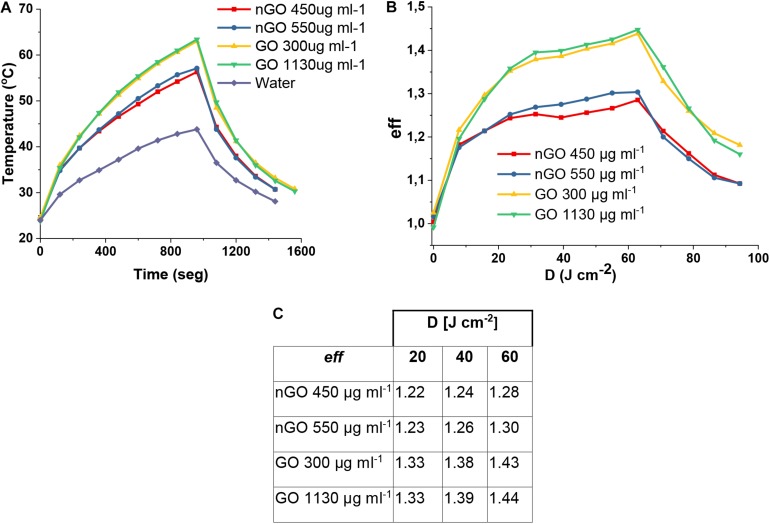
(A) Average temperature of GO and nGO. (B) PTT heating efficiency (eff). (C) Box summary of eff.